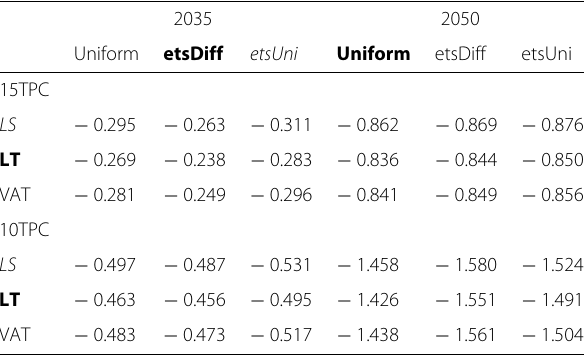
Table 6 Percentage change of MI from BAU for different years and